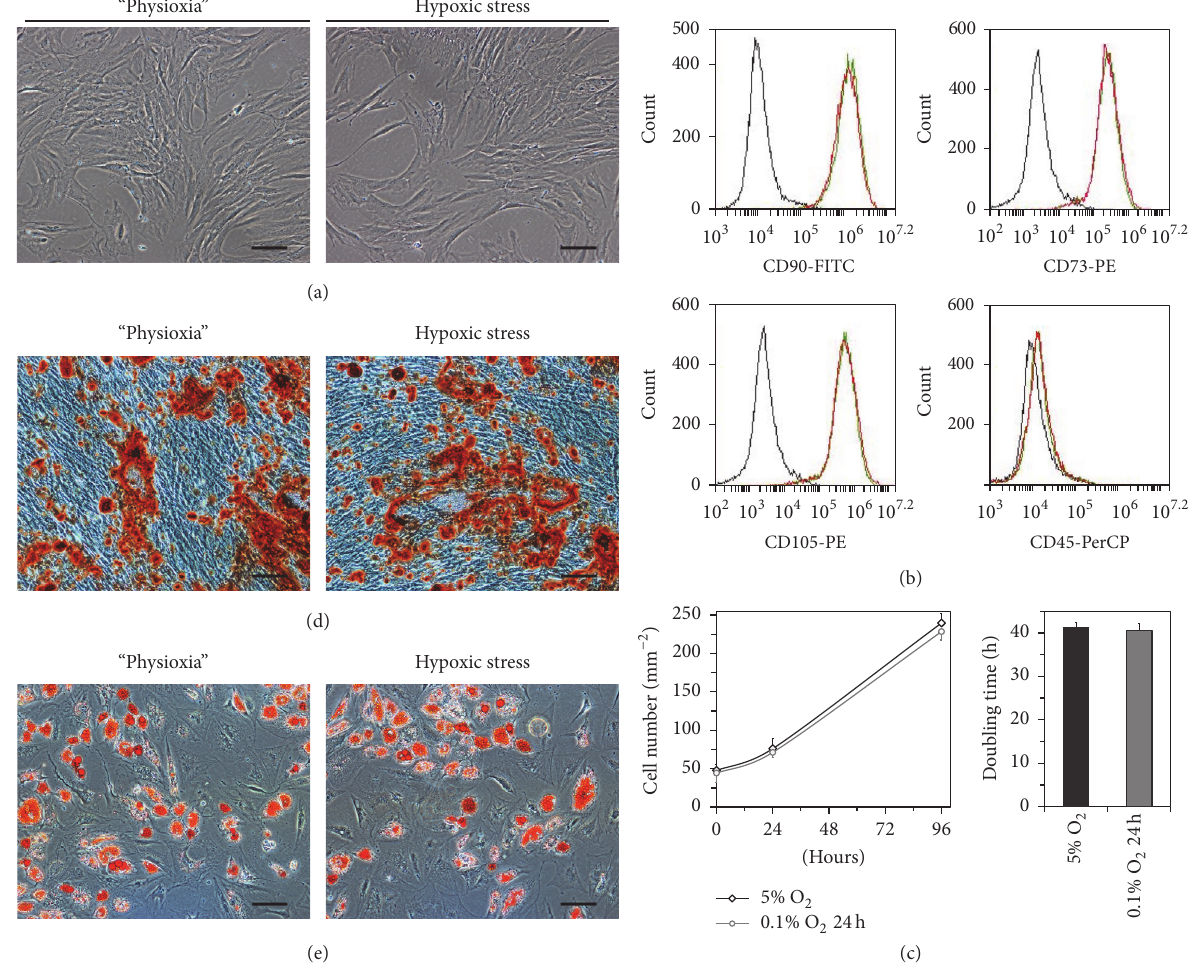
Figure 1: Adipose tissue-derived mesenchymal stromal cells (ASCs) under physioxia (5% O 2 ) and short-term hypoxic stress (0.1% O 2 , 24 h). (a) Phase-contrast microscopy of ASCs showed no morphological differences (scale bar, 100 𝜇 m). (b) The phenotype of ASCs was identified by flow cytometric analysis. ASCs were positive for CD73, CD90, and CD105 and negative for CD45. The black line indicates the isotype control, the green line indicates tissue O 2 -adapted ASCs, and the red line indicates ASCs after short-term hypoxic stress. (c) Cell growth was evaluated by growth curves and population doubling time over 4 days. The data are presented as the mean ± standard deviation ( 𝑛 = 3 ). (d) Osteogenic and (e) adipogenic induction was assessed by alizarin red S staining of the mineralized matrix and Oil Red O staining of intracellular neutral lipid droplets, respectively (scale bar, 100 𝜇